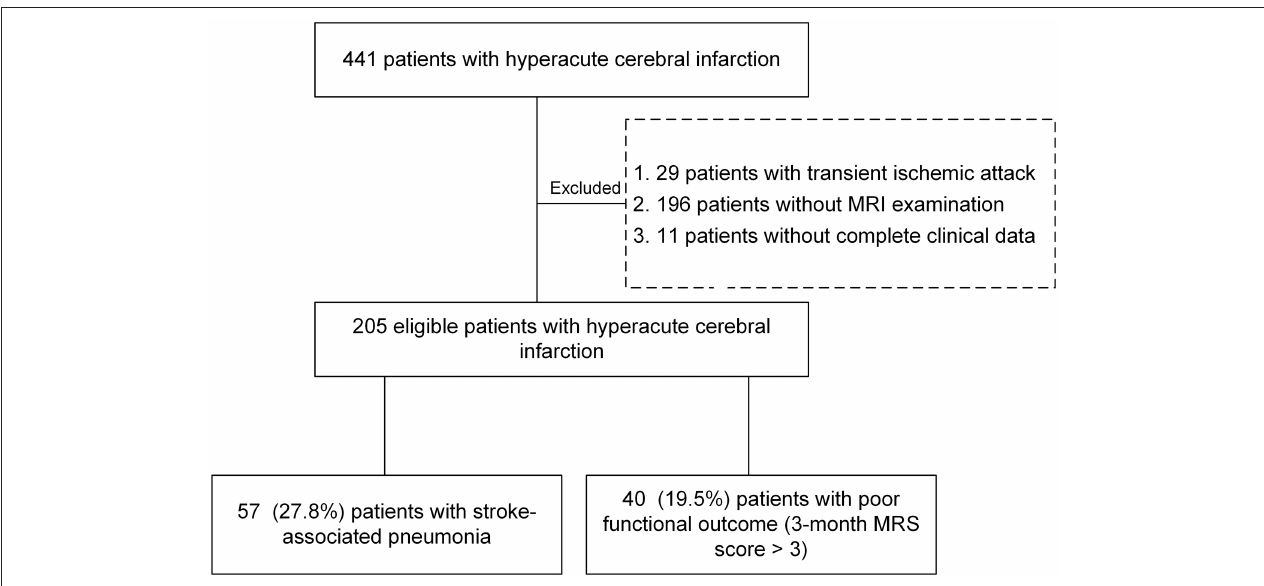
FIGURE 1 | Flow chart for the study patients. A total of 205 patients were included in this